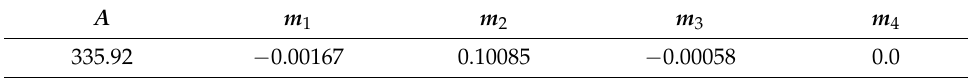
Table 4. Hensel–Spittel model constants for